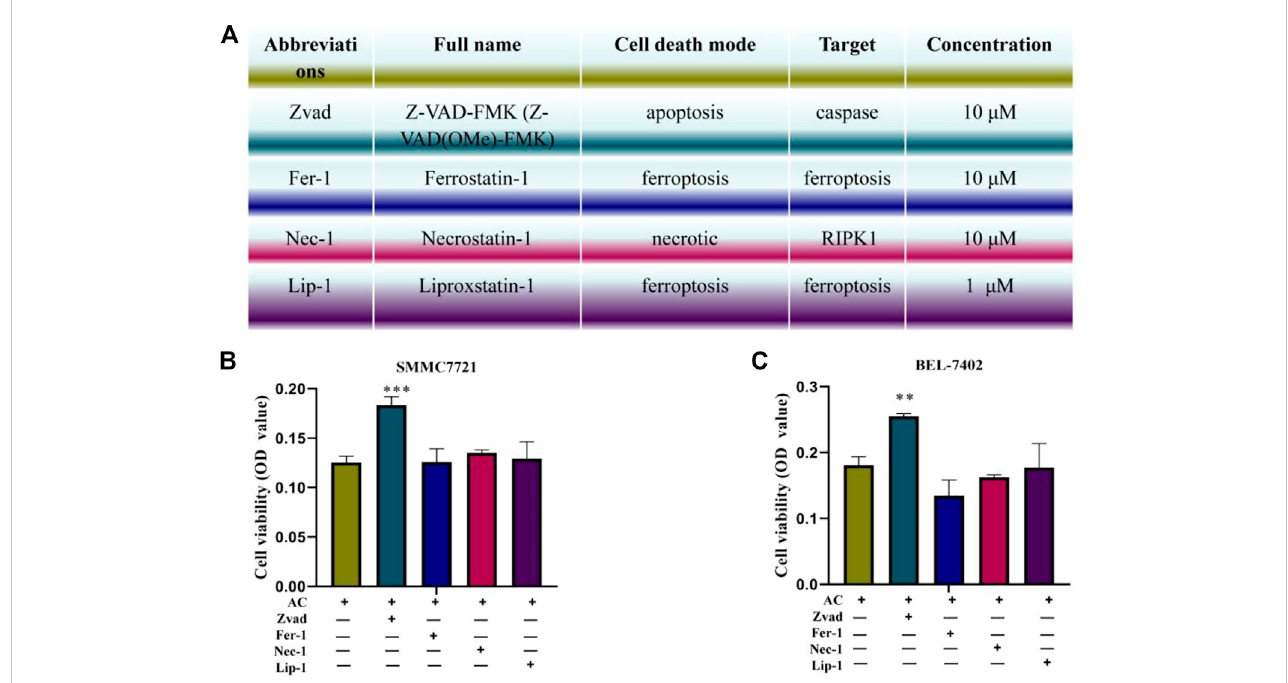
ThecelldeathmodeinducedbyAC. (A) Fullnames,concentrations,andtargetsoftheinhibitorsZvad,Fer-1,Lip-1,andNec-1. (B , C) Reverseeffectofthe inhibitors Zvad, Fer-1, Lip-1, Nec-1 on AC-induced death of hepatocellular carcinoma cells induced by AC. * means compared with AC group, ** p <